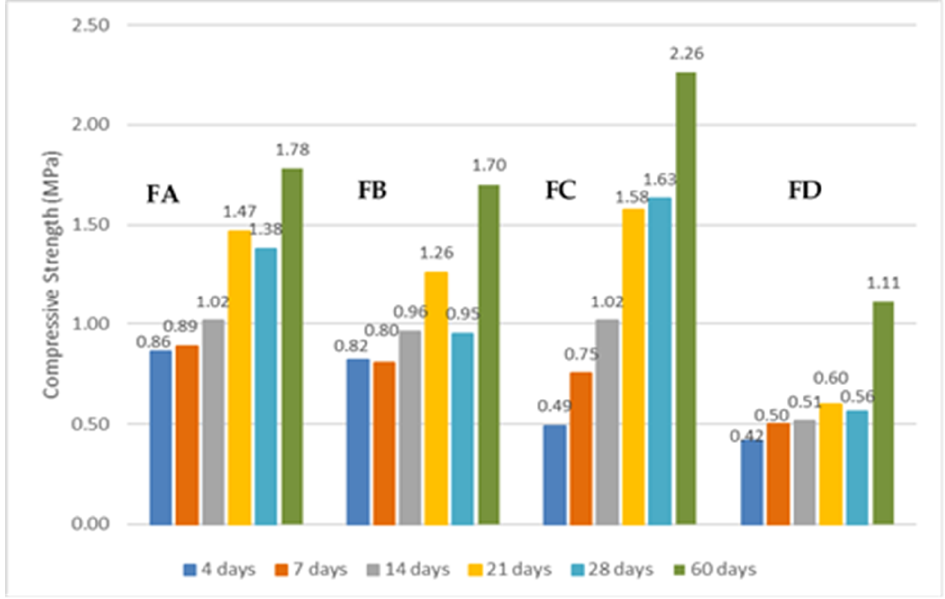
Figure 14. Effects of increase percentage of ecobinder on Villeray TC.